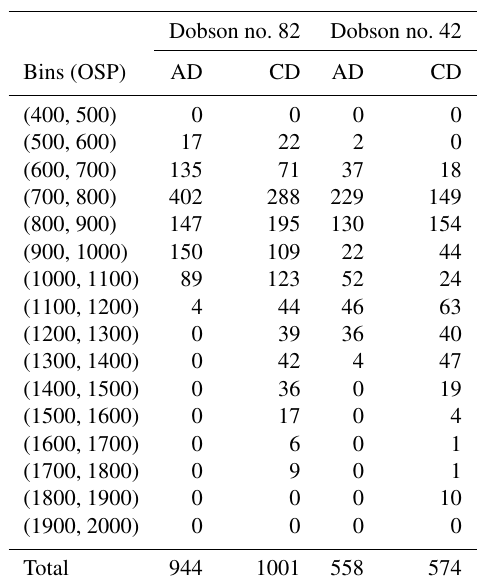
Table 7. The number of quasi-simultaneous measurements (within 5min) of Brewer no. 085 and Dobson no. 82 and no. 42, collocated at the South Pole station, divided into bins of OSP (see text and Fig. 11 for